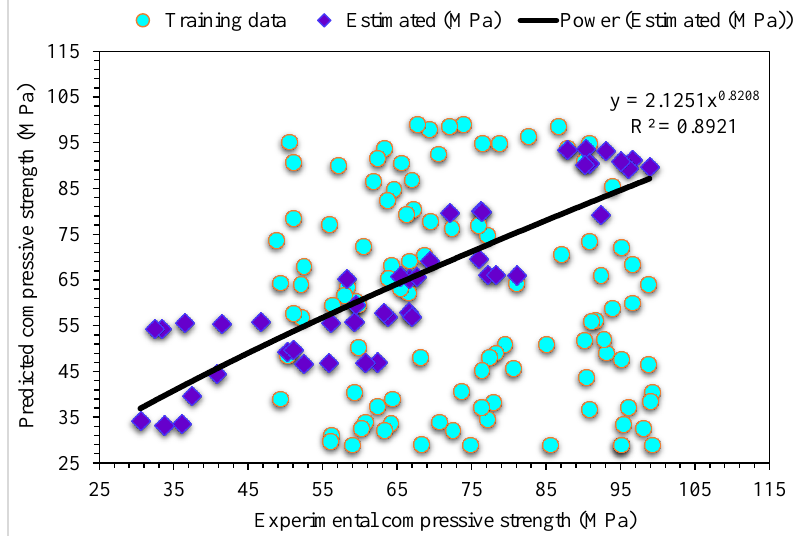
Figure 12. Experimental and MLPNN-Bagging predicted results for compressive strength.